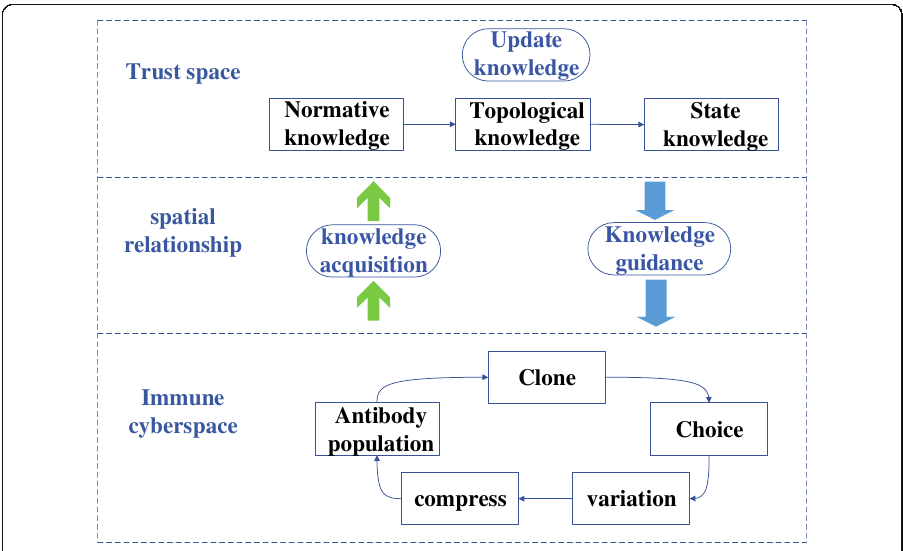
Fig. 1 AiNet clustering principle based on a cultural